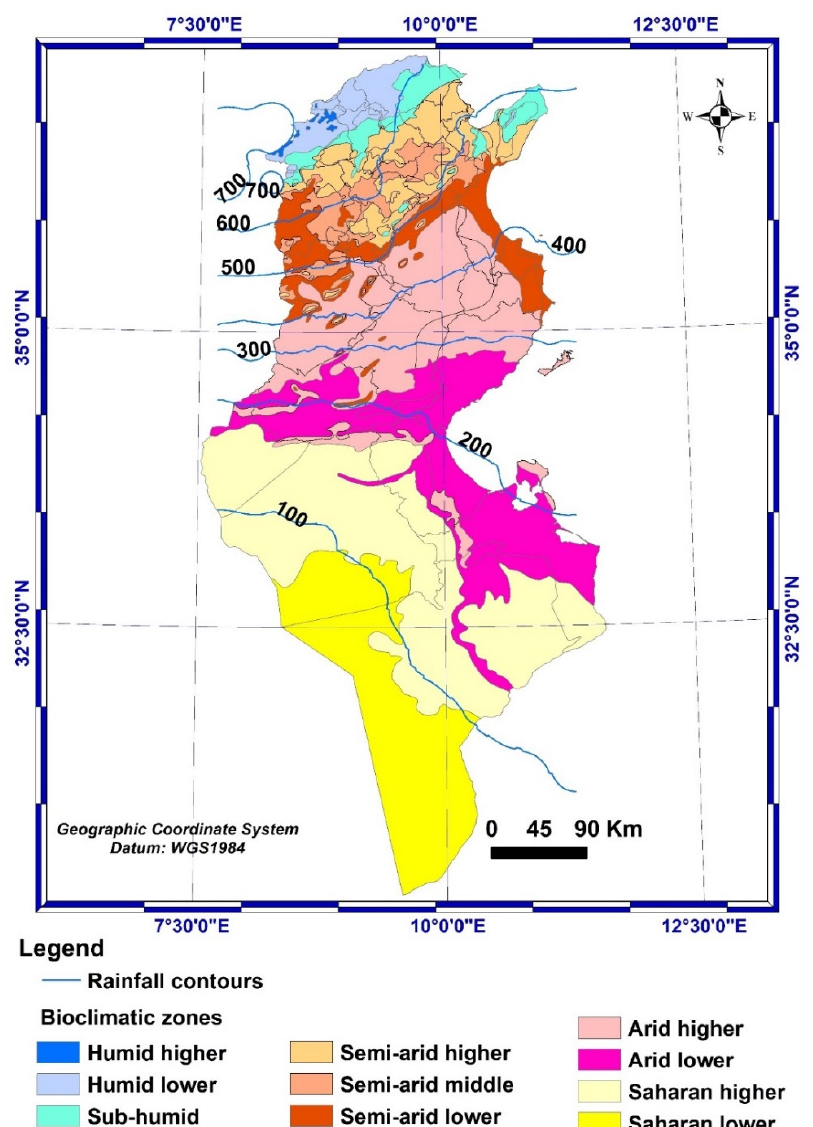
Figure 3. Bioclimatic map of Tunisia.